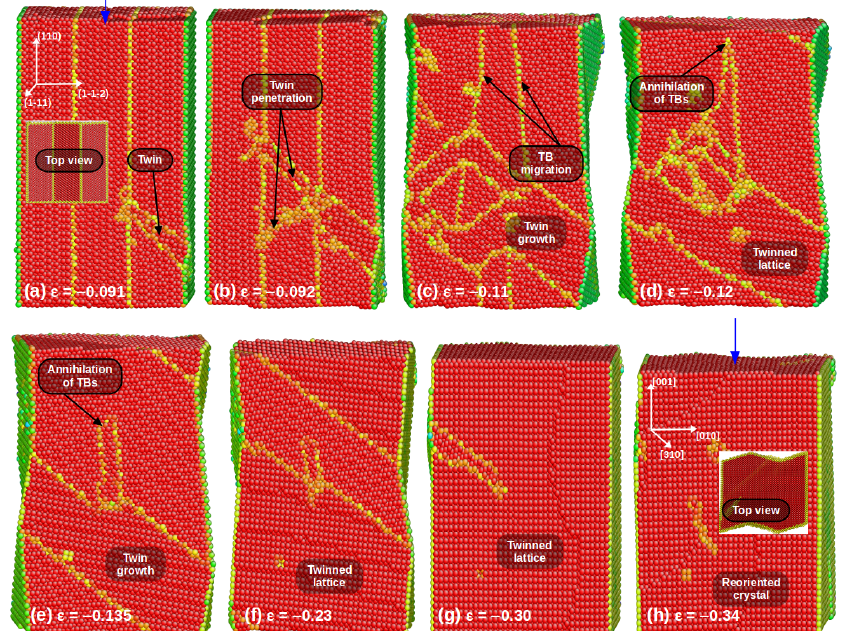
Figure 2. The atomic snapshots displaying the typical deformation behaviour in twinned BCC Fe nanowires at different strains; ( a ) twin nucleation, ( b , c ) twin penetration through existing TBs, ( c , d ) twin boundary migration and annihilation, ( d – g ) twin growth, and ( h ) reoriented nanowire. The atoms are coloured according to their centro-symmetry parameter (CSP). The insets in ( a , h ) shows the top view of the